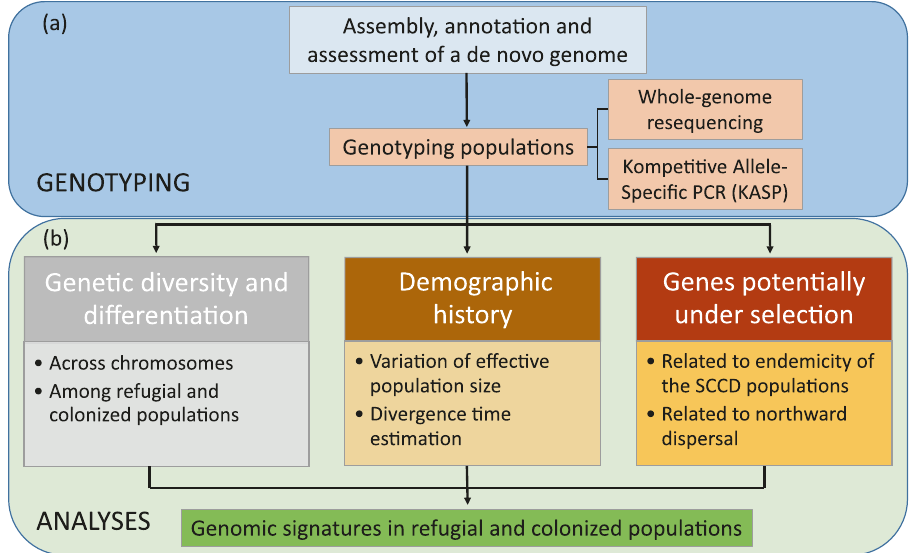
Fig. 2 Overview of approaches to investigate genomic signatures of the oriental fruit moth related to the Pleistocene climates. a Genotyping. Populations were genotyped using whole-genome resequencing and KASP methods based on a de novo assembled reference genome. b Data analysis. Genes potentially under selection were identi fi ed following genetic diversity, differentiation, and demographic history